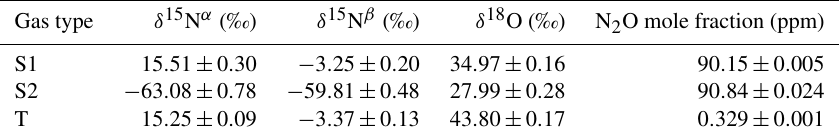
Table 2. Mole fractions and isotopic compositions of standard 1 (S1), standard 2 (S2), and target (T) gas cylinders that were used in this study. N 2 O mole fractions were analysed at Empa against standards from commercial suppliers (S1, S2) or from the National Oceanic and Atmospheric Administration, Earth System Research Laboratory, Global Monitoring Division (NOAA/ESRL/GMD) (T). N 2 O isotopic composition was also analysed at Empa against standards previously analysed by Sakae Toyoda, Tokyo Institute of Technology. The standard gas S1 is used for drift correction and standard gas S2 for a span correction of measured δ values. The indicated error is 1 standard deviation for replicate sample measurements and does not include the uncertainties of the calibration